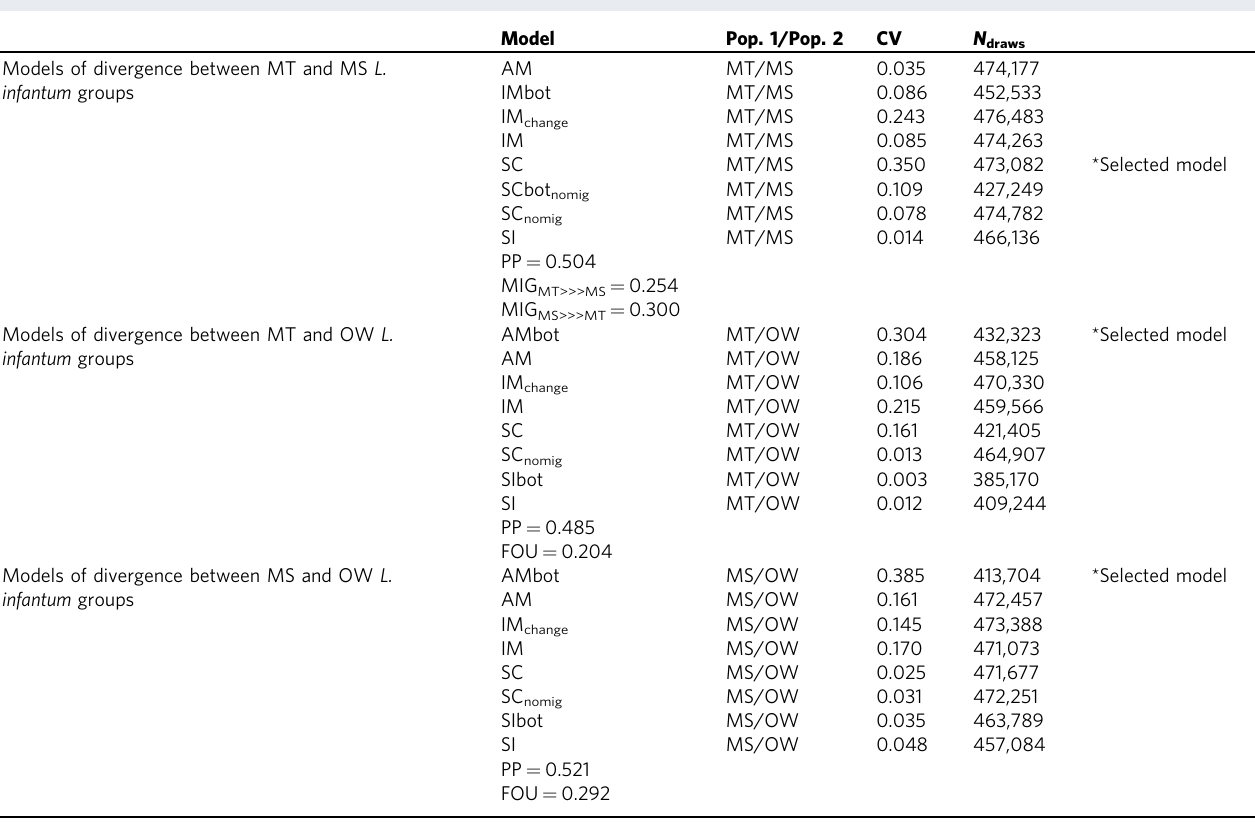
Table 2 Demographic simulation in fastsimcoal2 and model selection by Approximate Bayesian Computation via Random Forests (ABCRF).